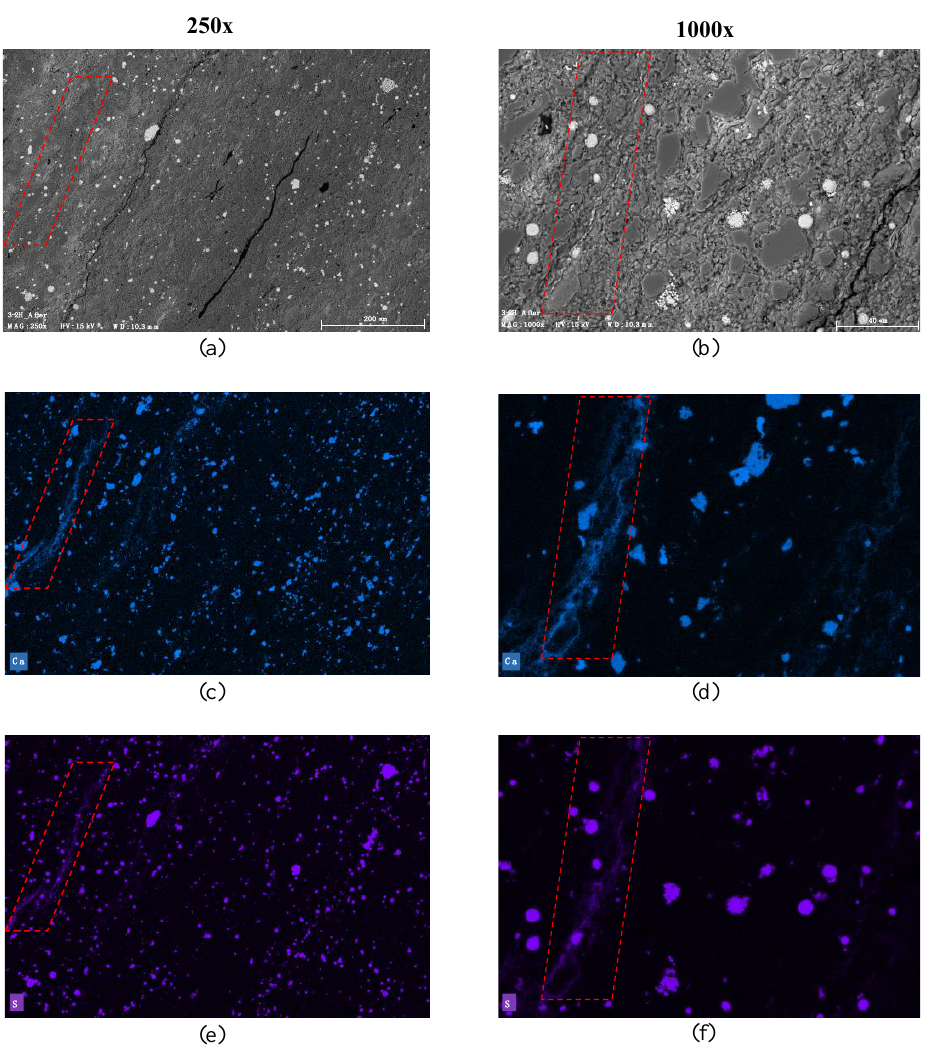
Figure 18. BSE images and EDS maps at two different magnifications in a region with precipitation of calcium sulfide ( a , b ) BSE images of the same region at two different magnifications of 250 × and 1000 × ; ( c , d ) the EDS maps for calcium at magnifications of 250 × and 1000 × ; ( e , f ) the EDS maps of sulfur at magnifications of 250 × and 1000 ×